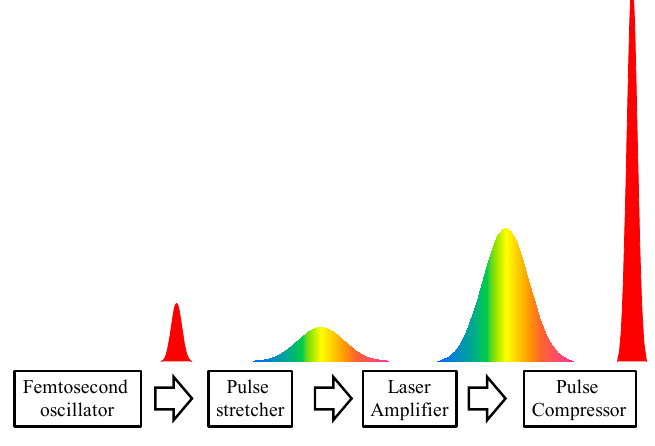
Figure 3. A schematic diagram of the drive laser system using the chirp pulse amplification